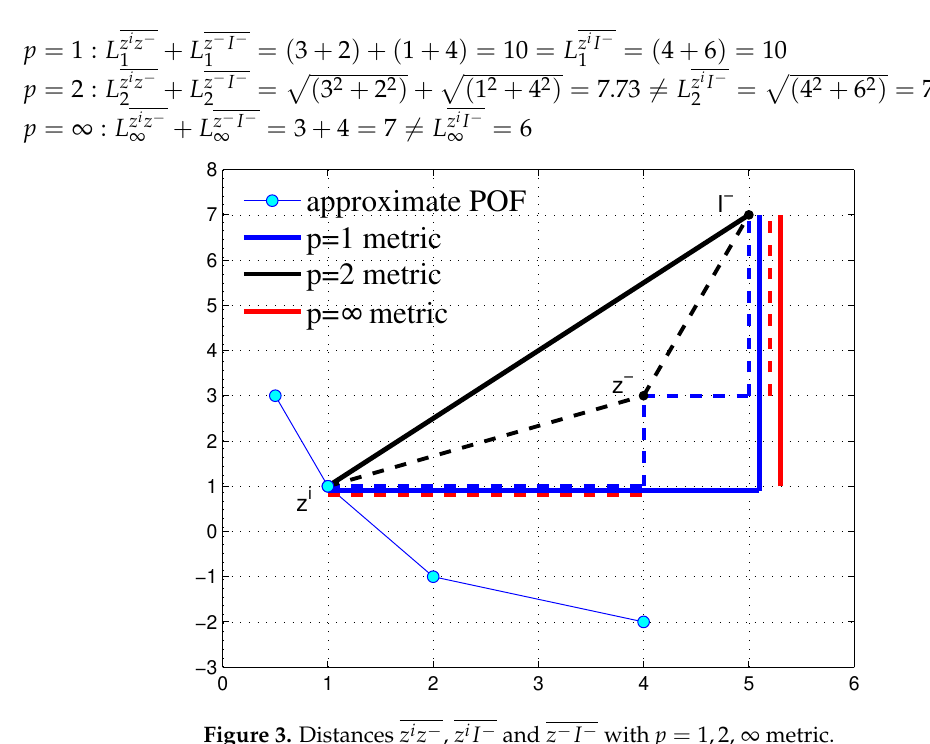
Figure 3. Distances z i z − , z i I − and z − I − with p = 1,2, ∞